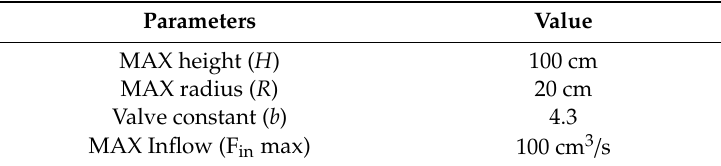
Table 5. Conical tank parameters